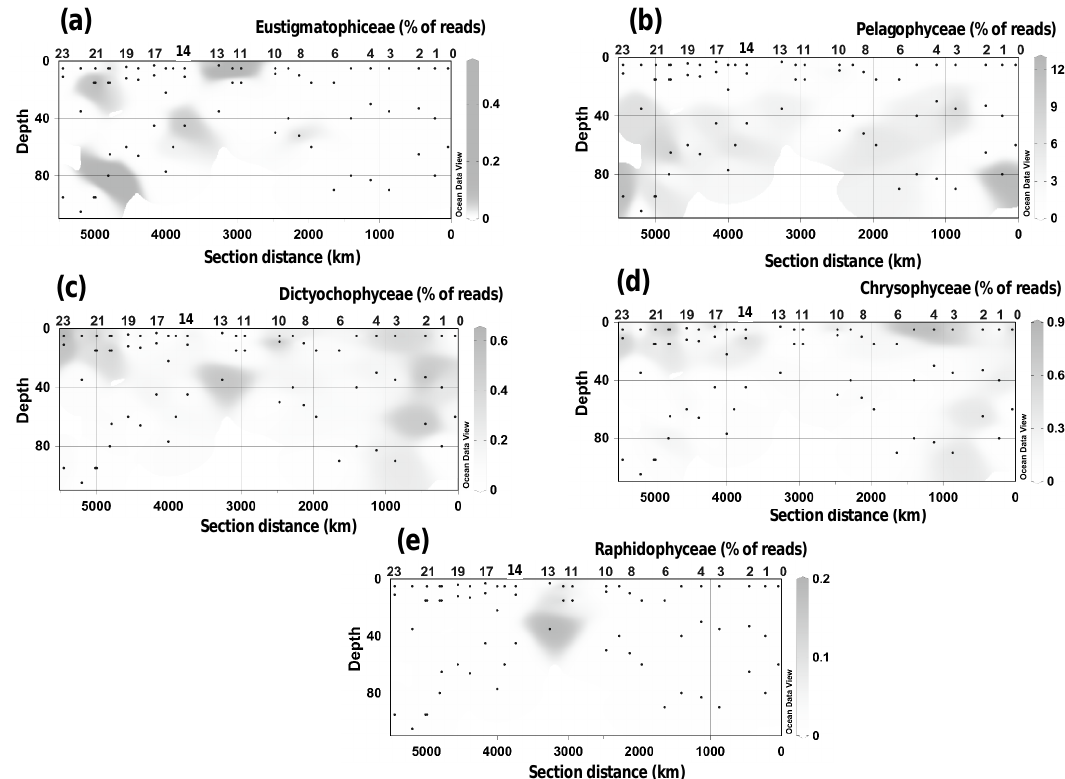
Figure 4. Spatial distribution of the 18S rRNA gene fragments related to taxa containing LCD producers at different stations and depth. (a) Pelagophyceae, (b) Chrysophyceae, (c) Dictyochophyceae, (d) radial centric diatoms, (e) Eustigmatophyceae, and (f) Raphidophyceae. Data were plotted using ODV software using kriging for interpolation between data points (Schlitzer,